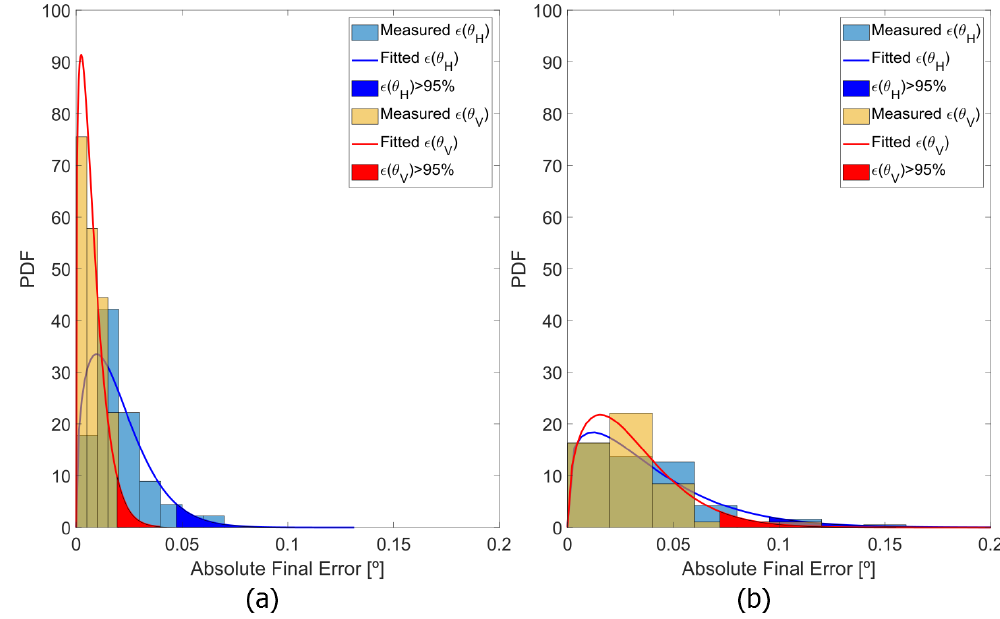
Figure 10. Probability Density Function (PDF) of both angular errors, ( blue ) horizontal and ( red ) vertical, of the odd lines for both ( a ) 30 × 20 ◦ FOV prototype and ( b ) 50 × 20 ◦ FOV prototype, using the mapping function Map 3 in Equation (13). The angular errors outside the 95% confidence interval are the filled